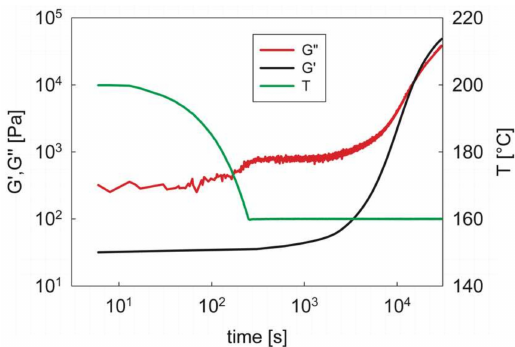
Figure 5. The elastic and loss modulus as a function of time in an isothermal experiment at 160 ◦ C. The temperature history is also reported on the right y -axis. G (cid:48) data have been smoothed for better